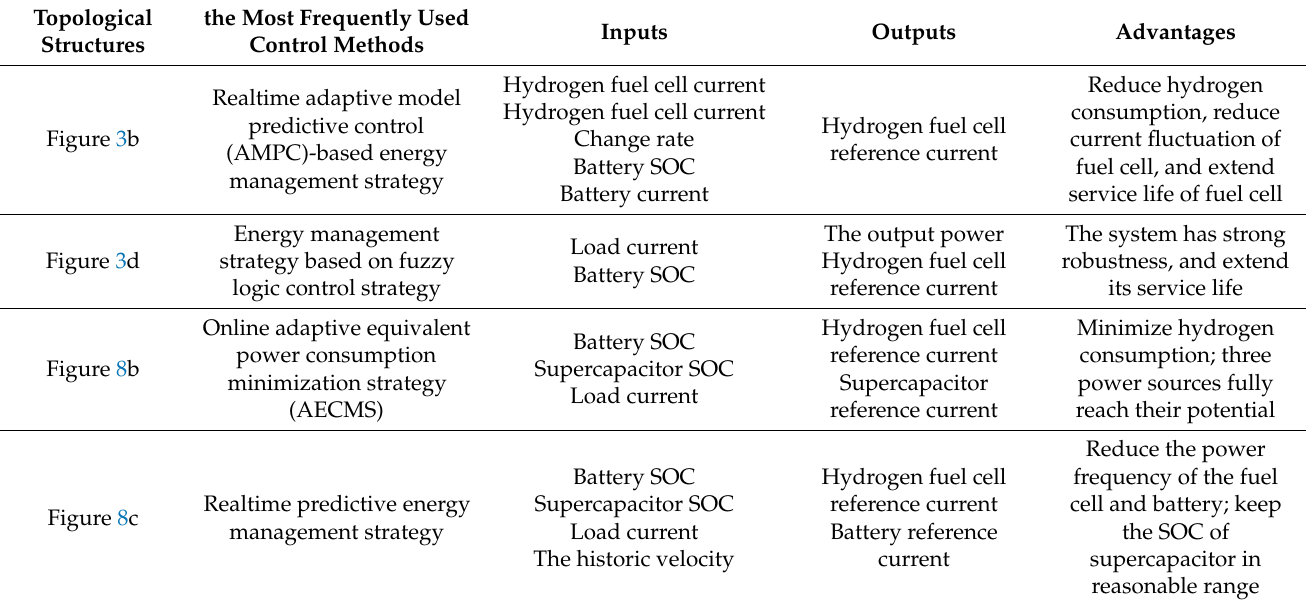
Table 1. Control schemes of several common